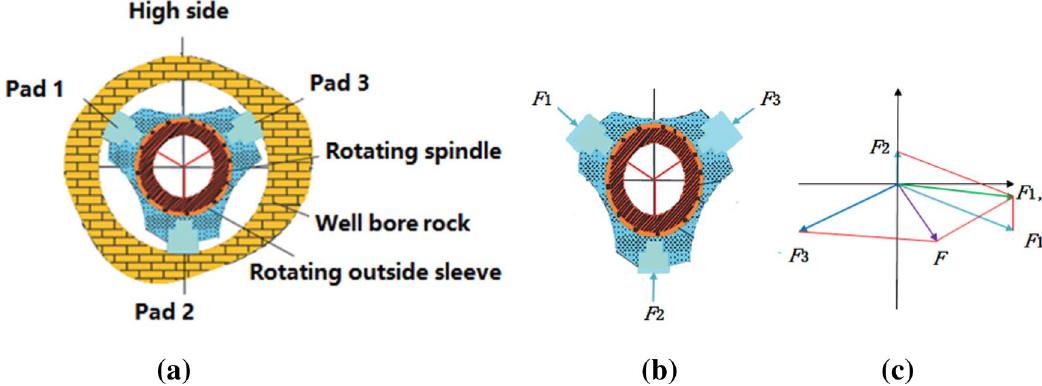
Fig. 1 Schematic of the structure and pad forces of a typical RSS